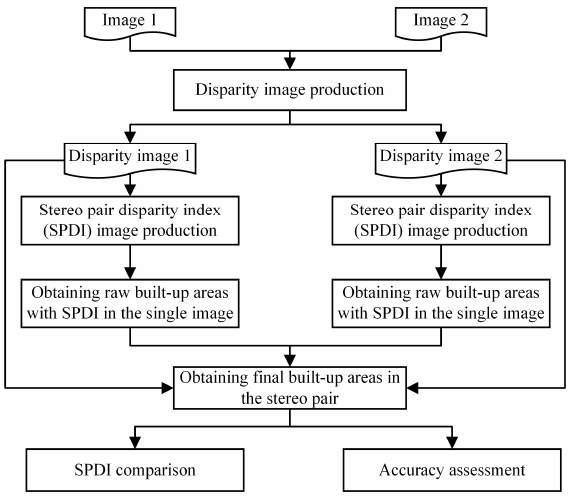
Figure 1. Flowchart of the proposed method for detecting built-up areas from a stereo